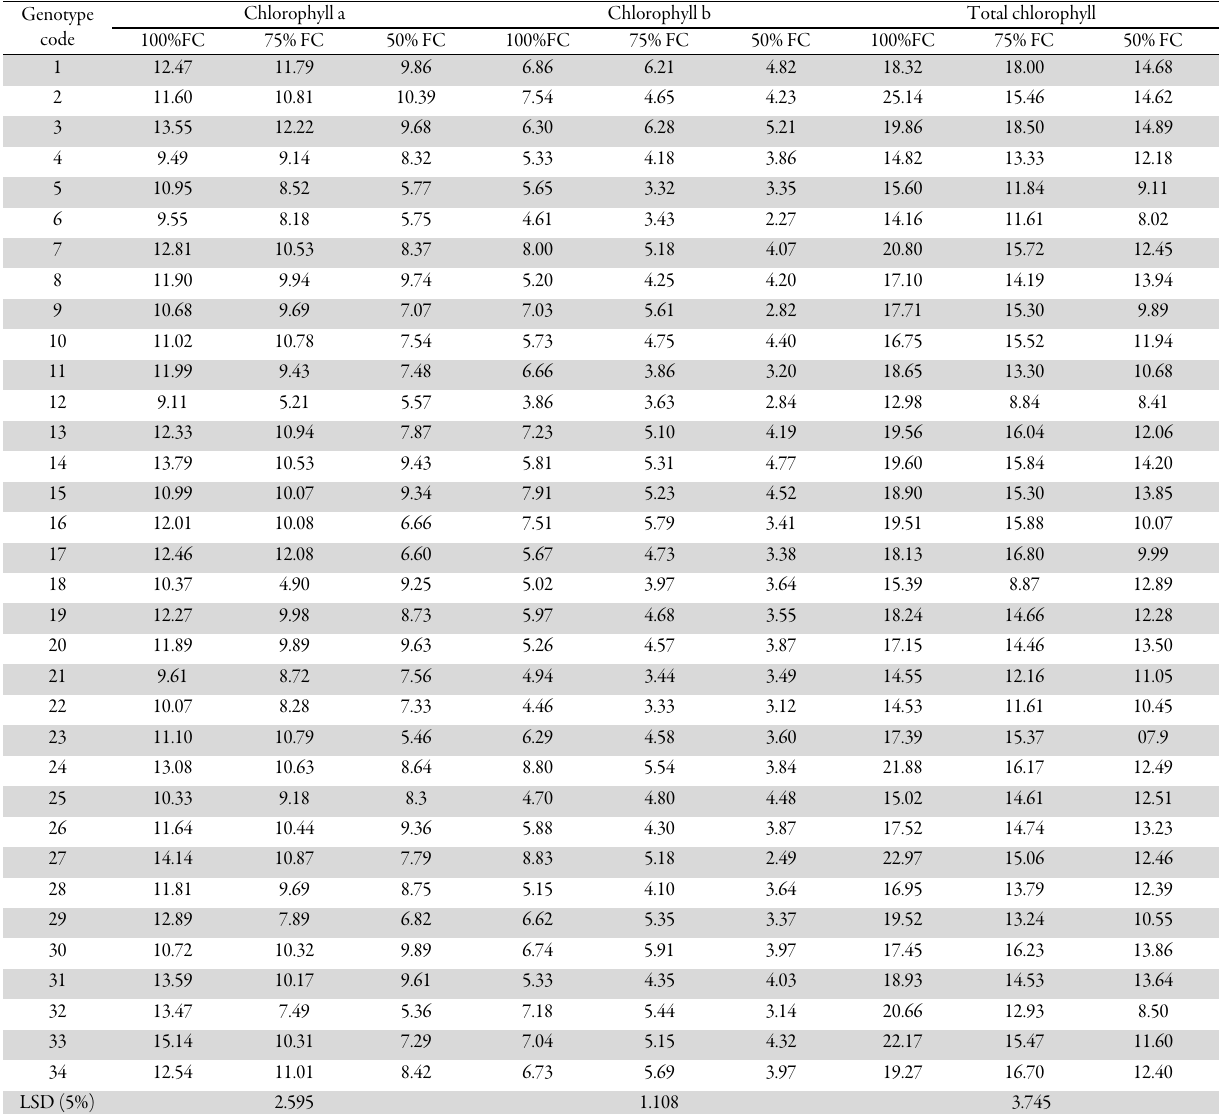
Table 4. Photosynthetic pigments; chlorophylls a, b and total (mg g -1 FW) for thirty-four wheat genotypes under different water deficit regimes and their corresponding LSD 5% values Genotype